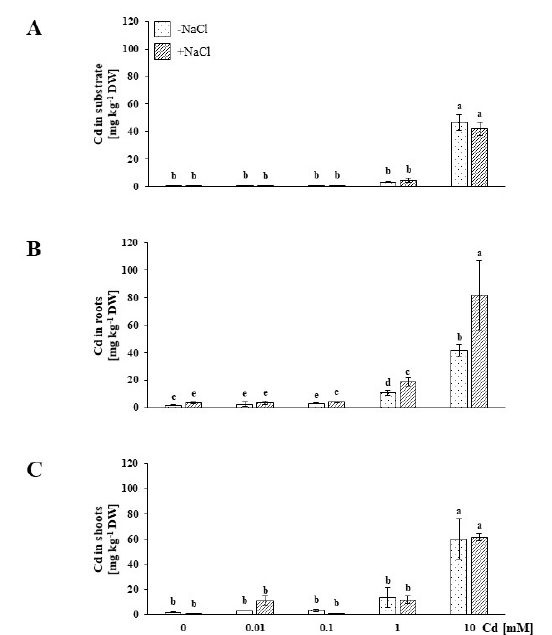
Figure 1. Contents measured in the substrate ( A ), roots ( B ) and shoots ( C ) of soil-grown NaCl-untreated ( − NaCl) and salt-stressed ( + NaCl) Mesembryanthemum crystallinum plants subjected to concentrations of 0.01, 0.1, 1, 10 mM Cd and the control (0.0 mM). Di ff erent letters above the bars indicate statistically significant di ff erences at p ≤ 0.05 by Duncan’s post hoc test ( N = 4, mean value ±SD).